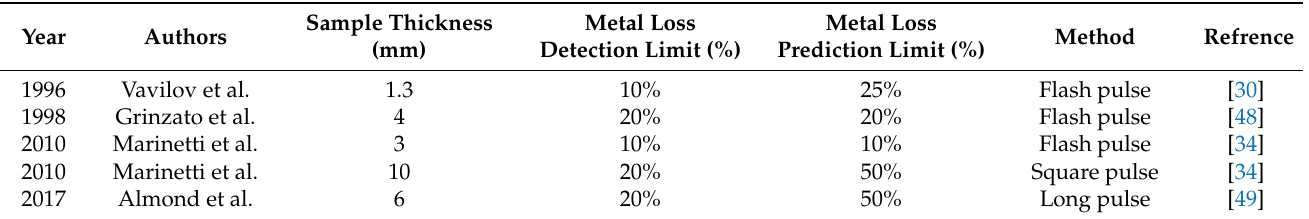
Table 4. A summary of defect detection and characterisation limits in mild-steel specimens reported in the